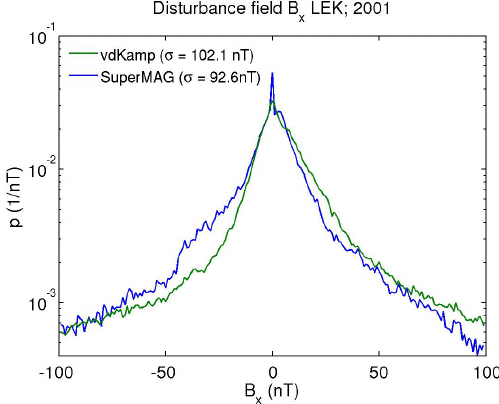
Fig. 15. B x field measured in Leknes on 1–9 May 2001 (red), the baseline from this paper (green), and the SuperMAG baseline (blue).